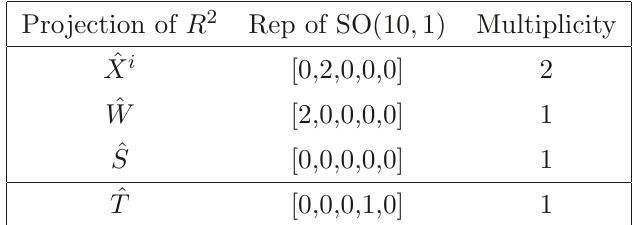
Table 1 . Valid embeddings of